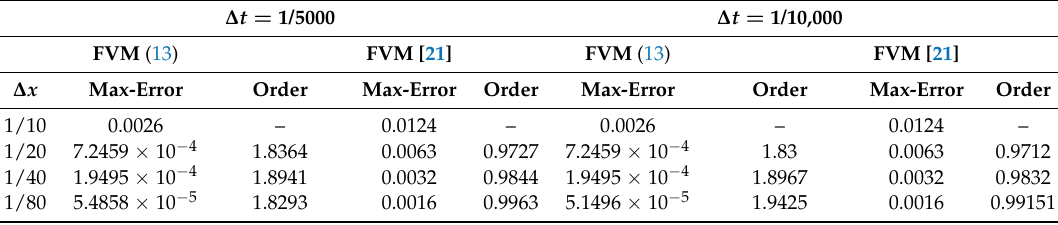
Table 5. Spatial convergence order of new upwind FVM and existing upwind approach of FVM taking k = 0.7, v = 0.05 in case of diffusion dominance.